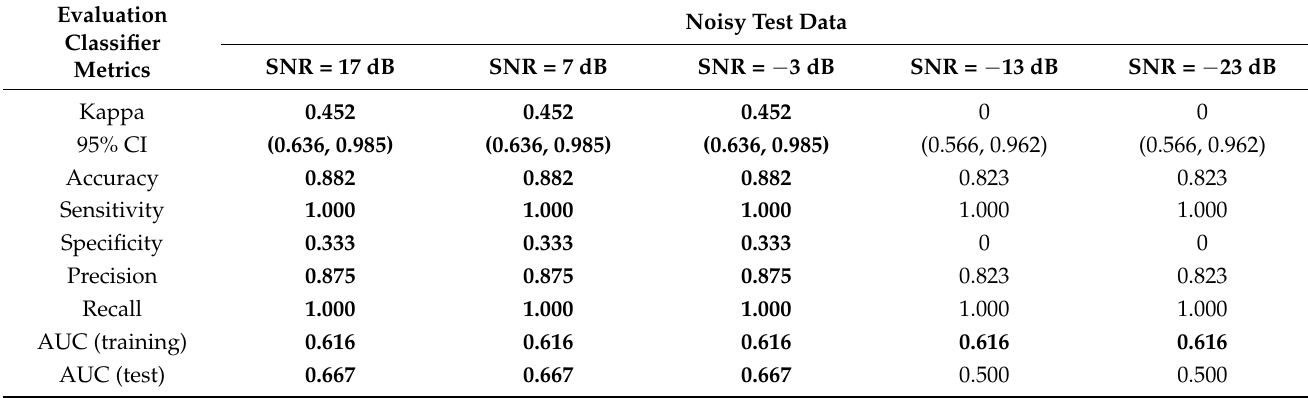
Table 4. ML evaluation parameters for binary RF trained and validated on original dataset, and further tested on noisy data with different noise levels. The best results are presented in bold. SNR stands for Signal-to-Noise Ratio, CI stands for Confidence Interval, and AUC stands for Area Under the Curve. Two AUC values are presented for the validation set and for the test